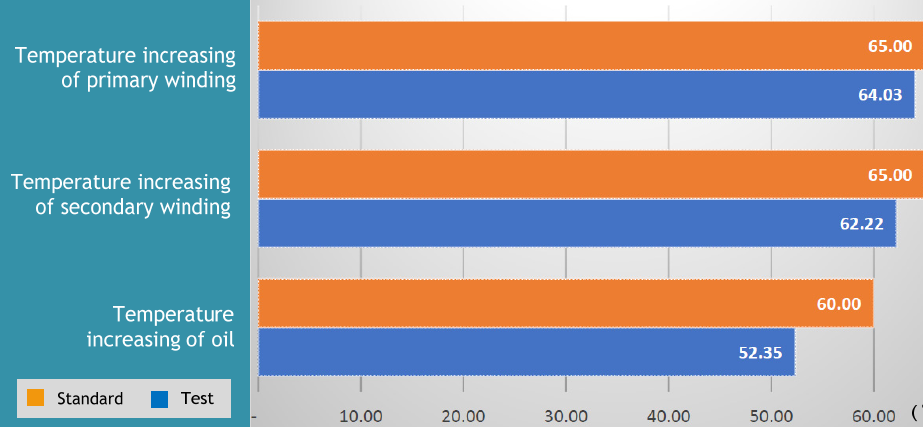
Figure 14. The temperature comparison between IEC 60076 standard and transformer test result.